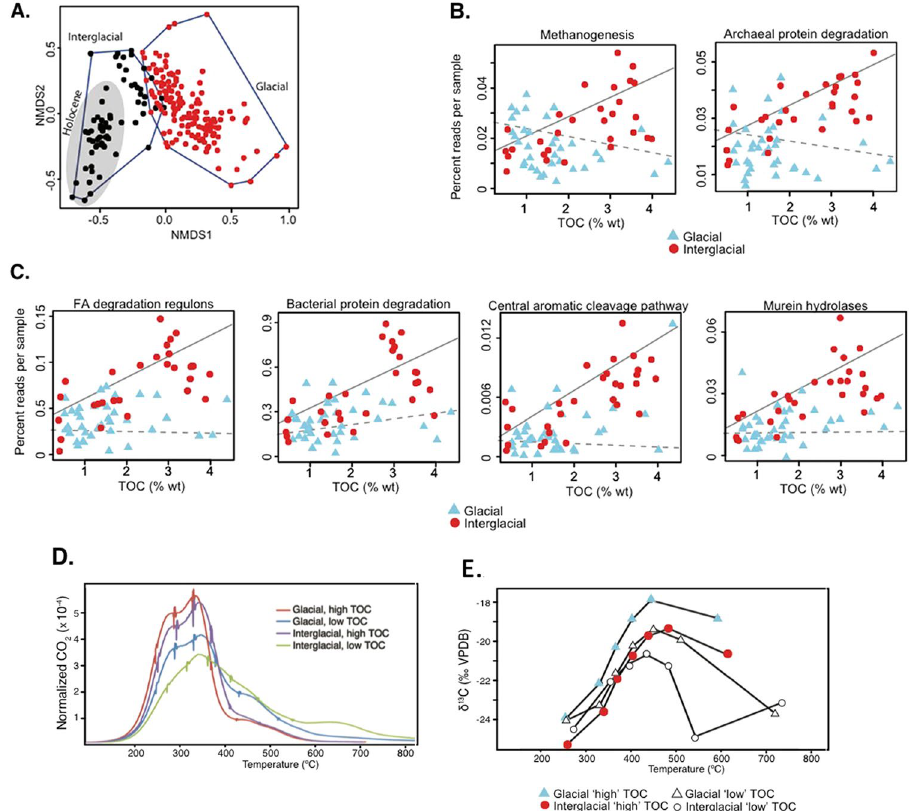
Figure 3. ( A ) Non-metric multidimenstional scaling analysis of 16S rRNA genes showing different microbial communities in the Holocene (grey area), interglacial (black circles), and glacial (red symbols) periods (ANOSIM: P = 0.001; NMDS stress: 0.12). (B ) Correlations between SEED catabolic gene categories from Archaea and glacial v. interglacial TOC. Solid and dashed lines represent regressions for interglacial and glacial samples, respectively. ( C ) Correlations between SEED catabolic gene categories from Bacteria and glacial v. interglacial TOC. Solid and dashed lines represent regressions for interglacial and glacial samples, respectively. ( D ) Ramped PyrOx thermograms of glacial (IS4, 28 kyr) and interglacial (Holocene, 3.5 kyr) OM, and ( E ) the δ 13 C of eluted CO 2 . Thermograms are normalized such that the area under each curve is equal to